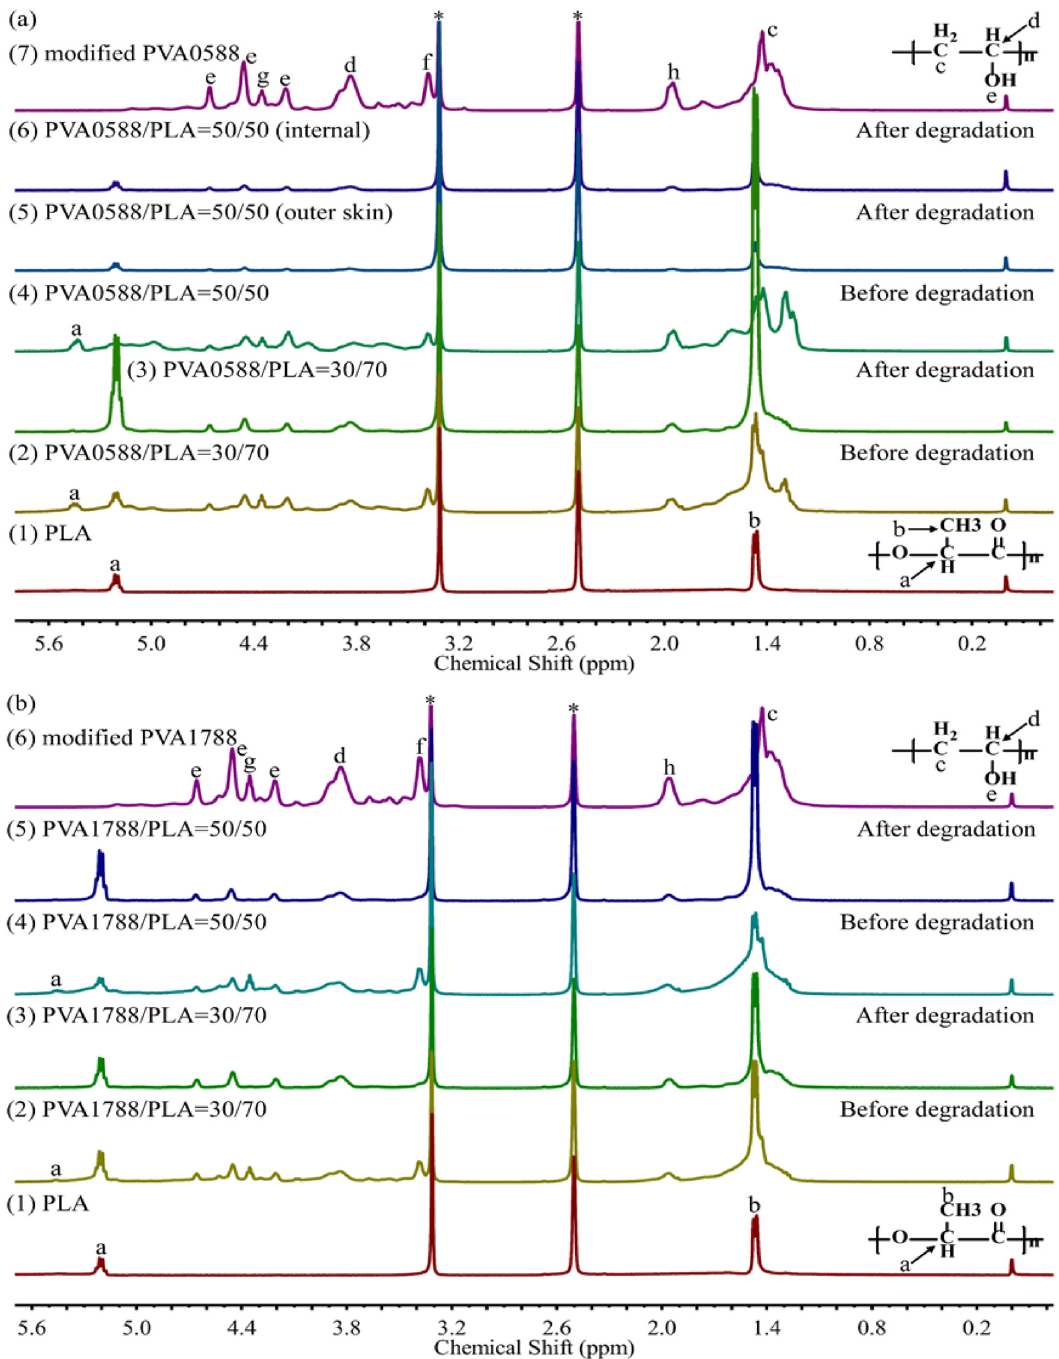
Figure 7: 1 H NMR spectra of PLA, modi fi ed PVA, and PVA/PLA blends before and after natural seawater degradation for 180 days: ( a ) modi fi ed PVA0588; ( b ) modi fi ed PVA1788, * represents the solvent DMSO absorption peak, letter h is the absorption peak of acetone, and other letters represent the characteristic peaks of di ff erent groups in the sample,